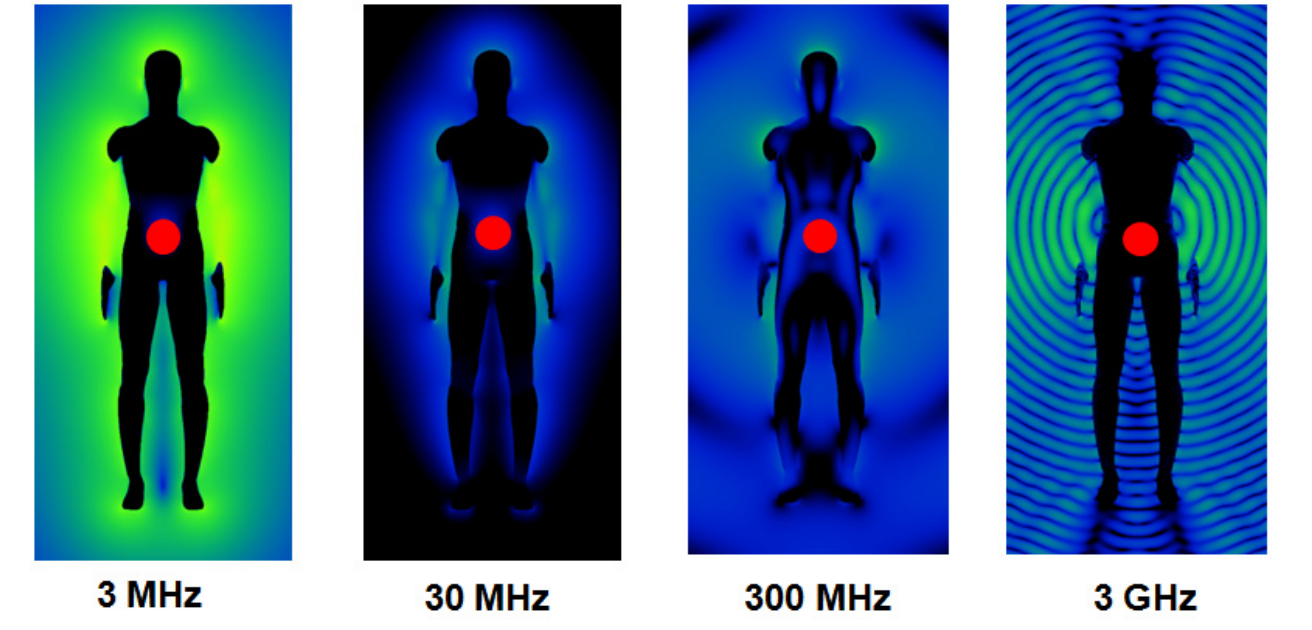
Figure 1. Electric field distributions at different frequency points.